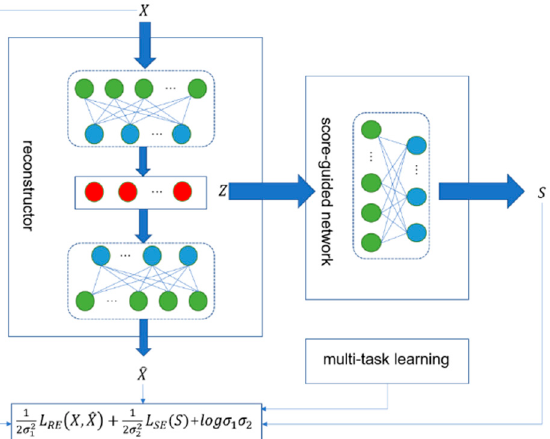
Figure 2. The unsupervised structural damage detection model’s overall schematic diagram.